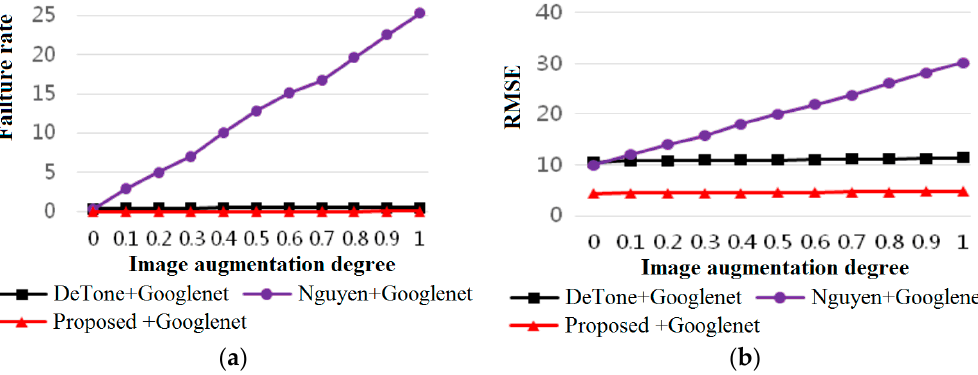
Figure 4. Robustness of DeTone’s algorithm, Nguyen’s algorithm and the proposed algorithm using